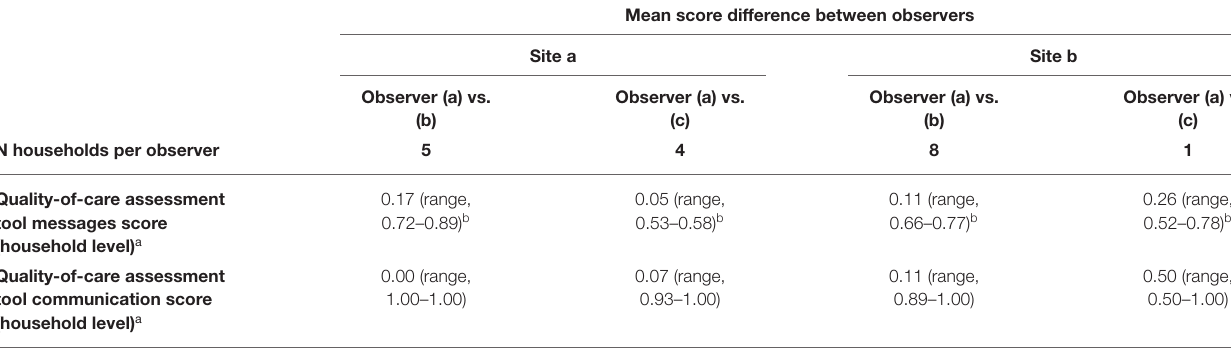
TABLE 4 | Quality-of-care mean messages and communication scores difference by paired observers by site.